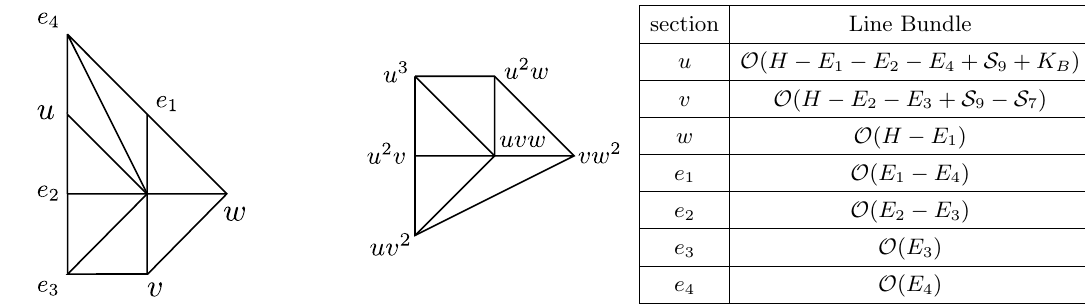
Figure 1 . The polytope F 11 and its dual. The table contains the divisor classes of the coordinates in P F 11